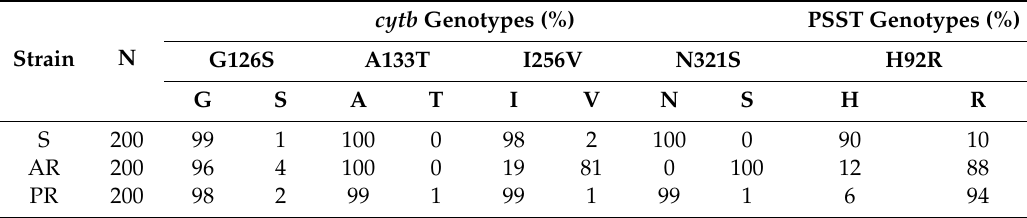
Table 4. Genotypes of point mutations in the cytb and PSST genes of Tetranychus urticae.